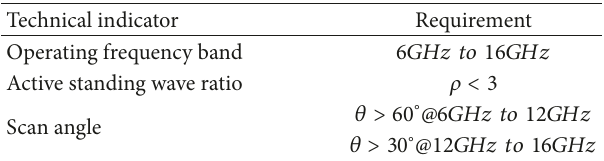
Table 1: Main technical specification of the DRA array. Technical indicator Requirement Operating frequency band Active standing wave